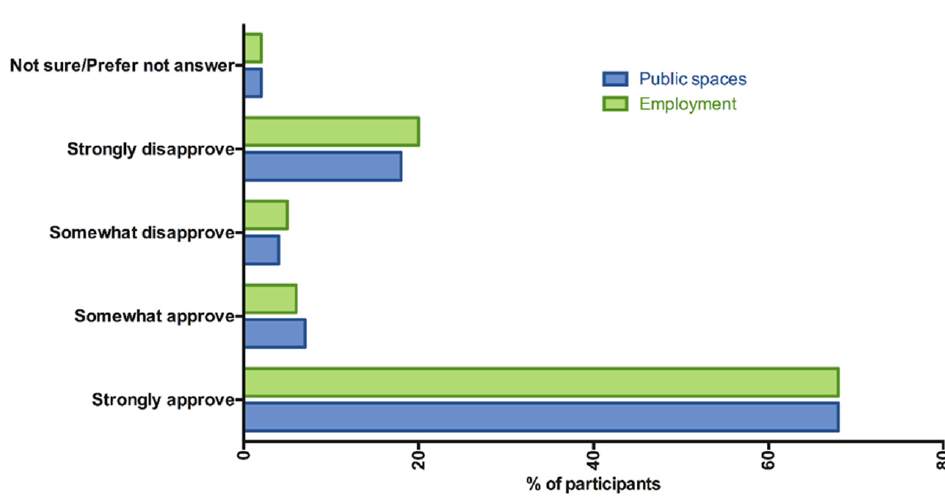
Figure 1. Attitudes to adult vaccine mandates. Study participants were asked: “Do you approve of the government requiring COVID-19 vaccine to get on public transportation?” or “Do you approve employers requiring a COVID-19 vaccine to get a job or certain pay allowances?”.